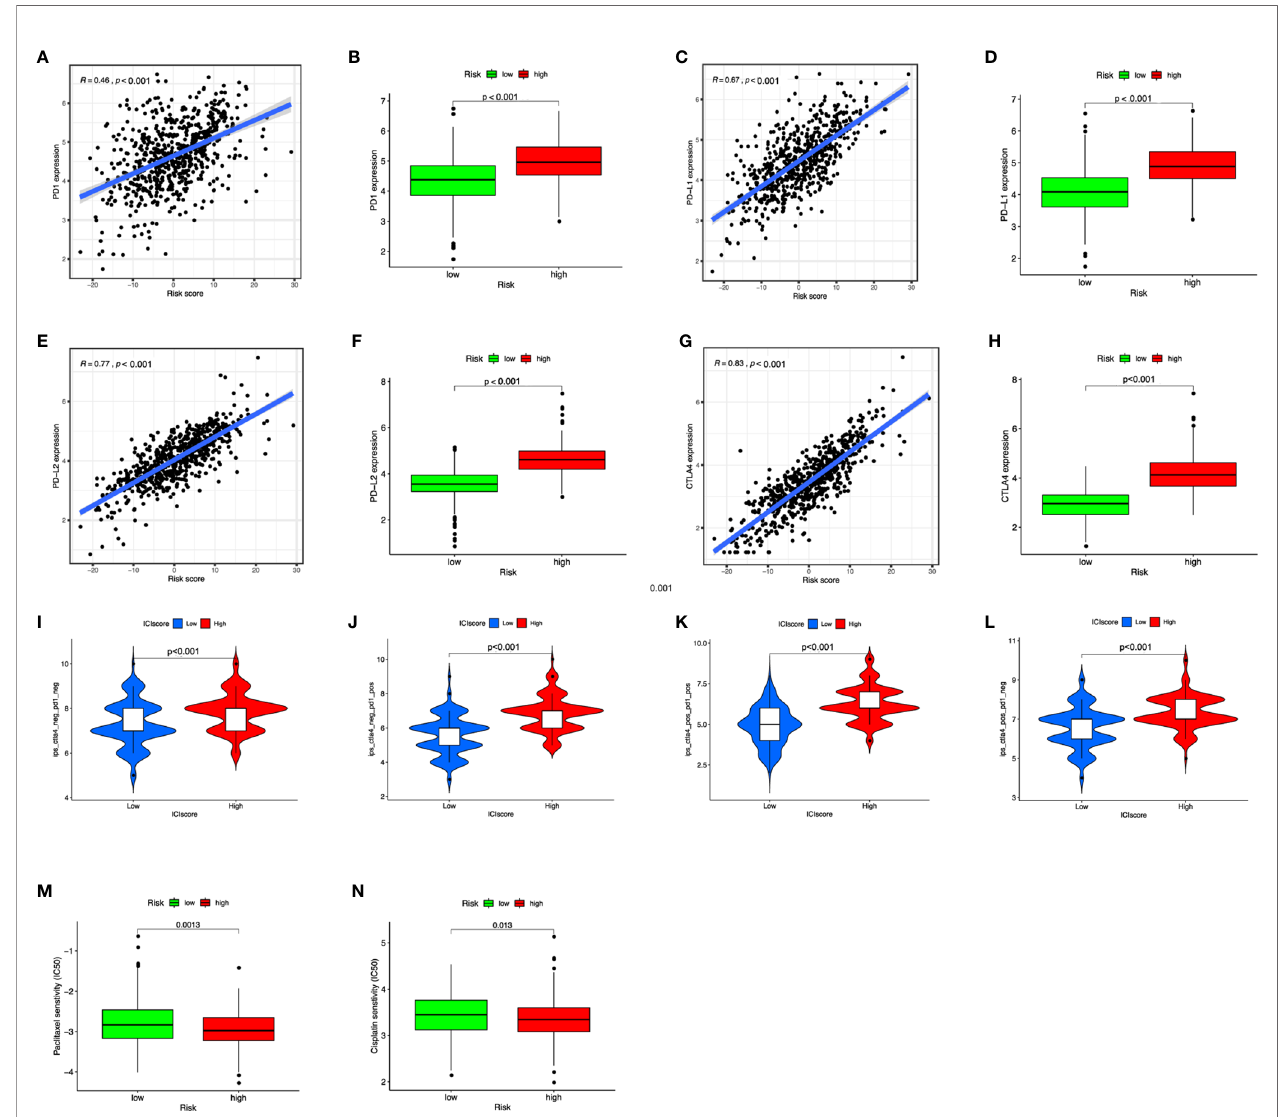
FIGURE 7 | The bene fi ts of ICI score in predicting immunotherapy. (A – H) Scatterplot and boxplot of PD1 (A , B) , PD-L1 (C , D) , PD-L2 (E , F) , and CTLA4 (G , H) expression in risk scores. (I – L) IPS values of patients categorized according to ICI score of four subtypes [IPS-CTLA4-neg-PD1-neg (I) , IPS-CTLA4-neg-PD1-pos (J) , IPS-CTLA4-pos-PD1-pos (K) , IPS-CTLA4-pos-PD1-neg (L) ]. (M , N) The IC50 of cisplatin and paclitaxel in low and high ICI